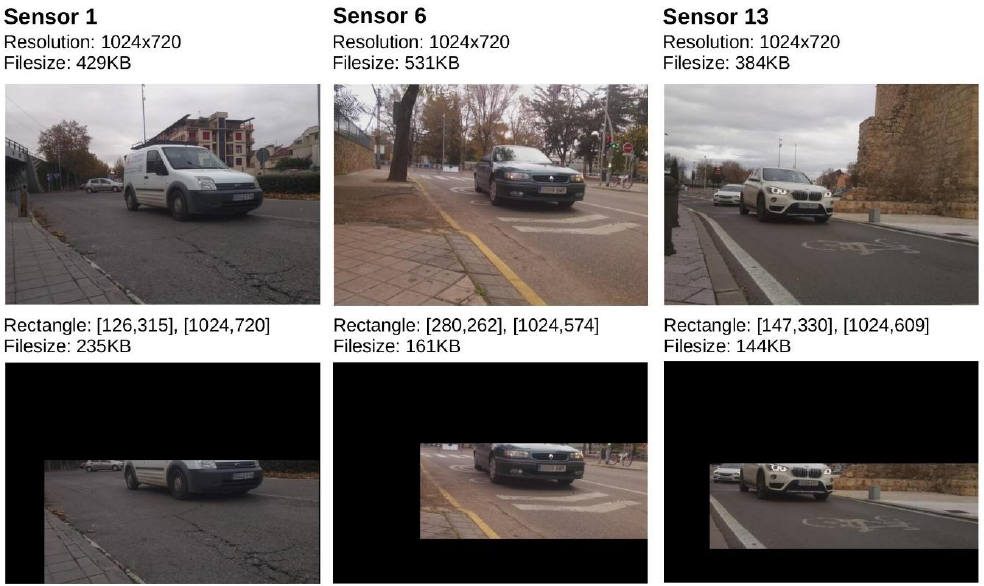
Figure 5. Example of definition of clipping parameters in capture sub-regions in three sensors of the deployed system, with comparative analysis of storage size for each frame. (To protect personal data, the first three digits of the license plate have been blurred).